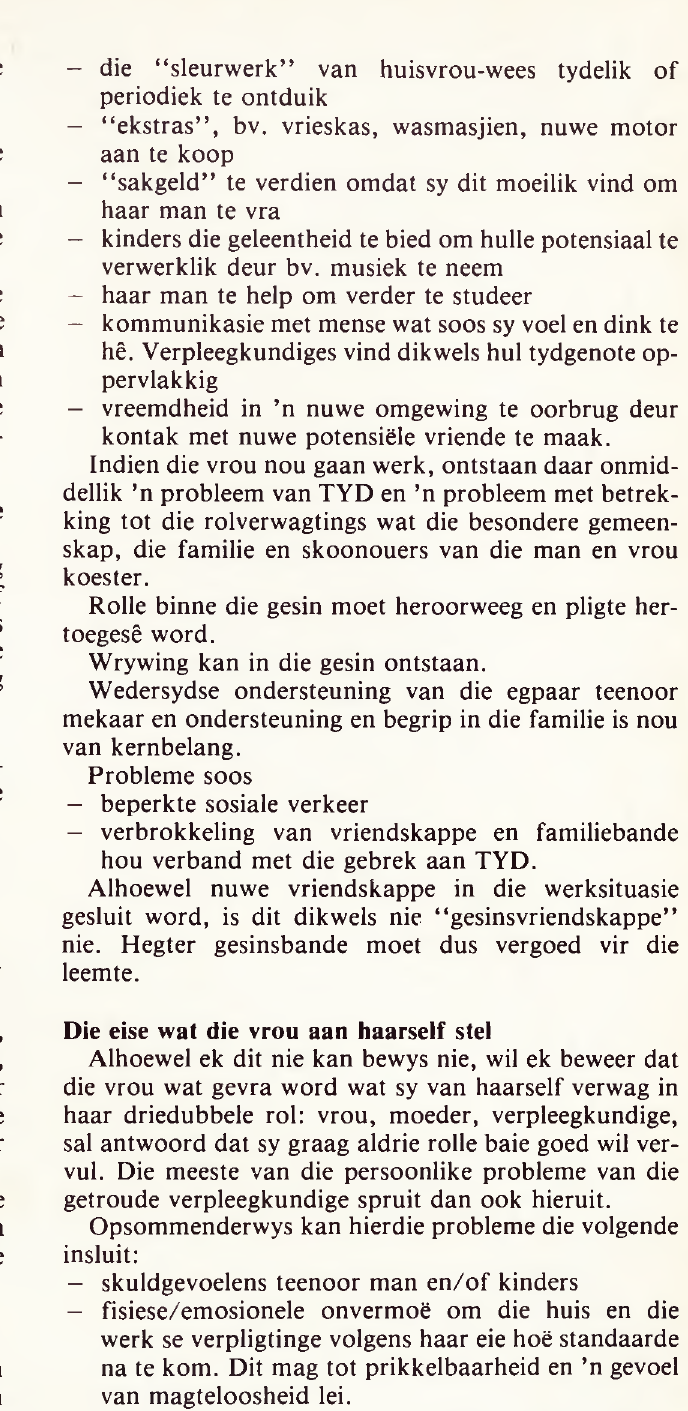
baba/peuter/kleuter reelings (vervanging van